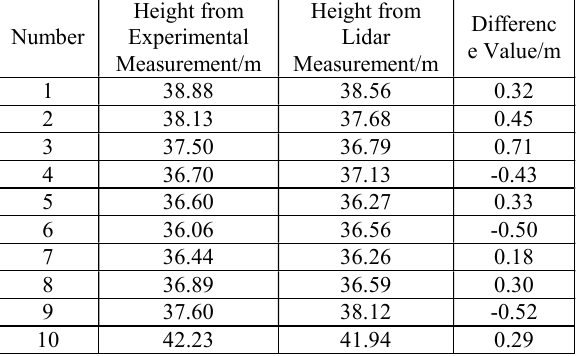
Figure 12. Airborne laser point cloud data